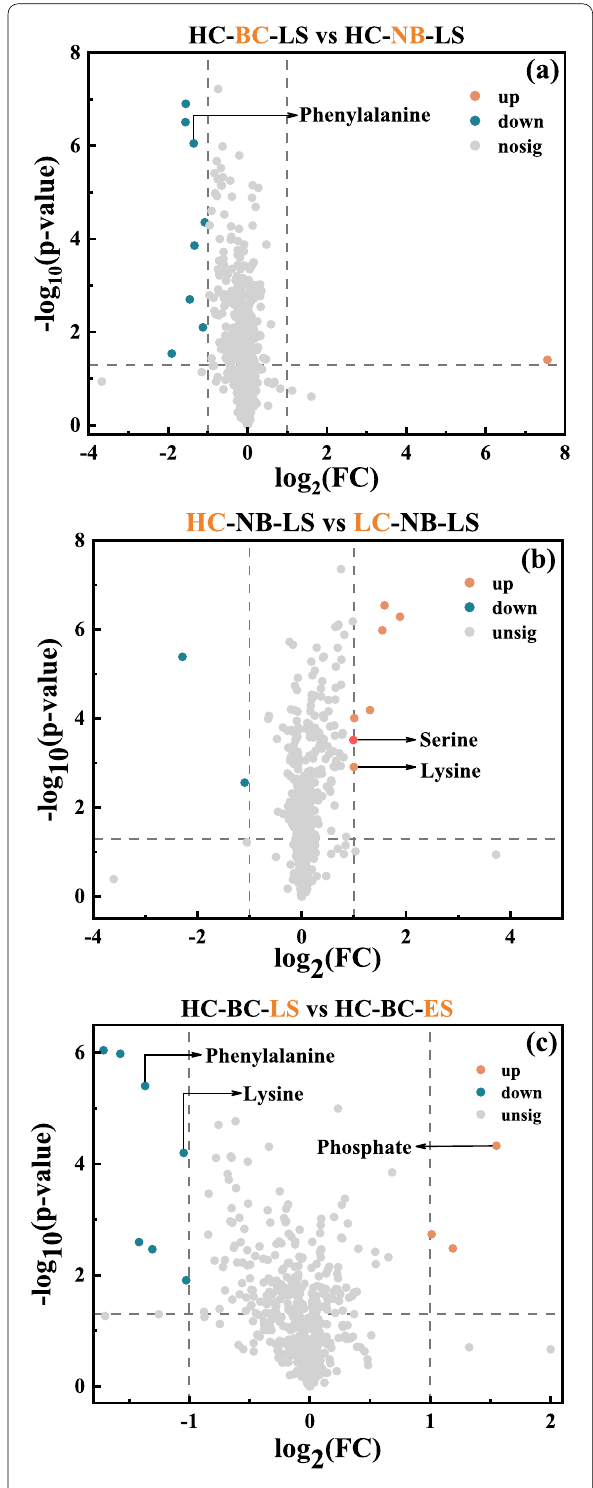
Fig. 6 Volcano plots showing changes in extracellular metabolite abundance between different comparisons. The horizontal and vertical dotted lines indicate the cutoffs for statistical significance. The colored markers indicate statistically significant metabolites that were present in higher (orange) or lower (blue) abundances. LC: Low concentration; HC: High concentration; ES: Supernatant collected at early stage; LS: Supernatant collected at late